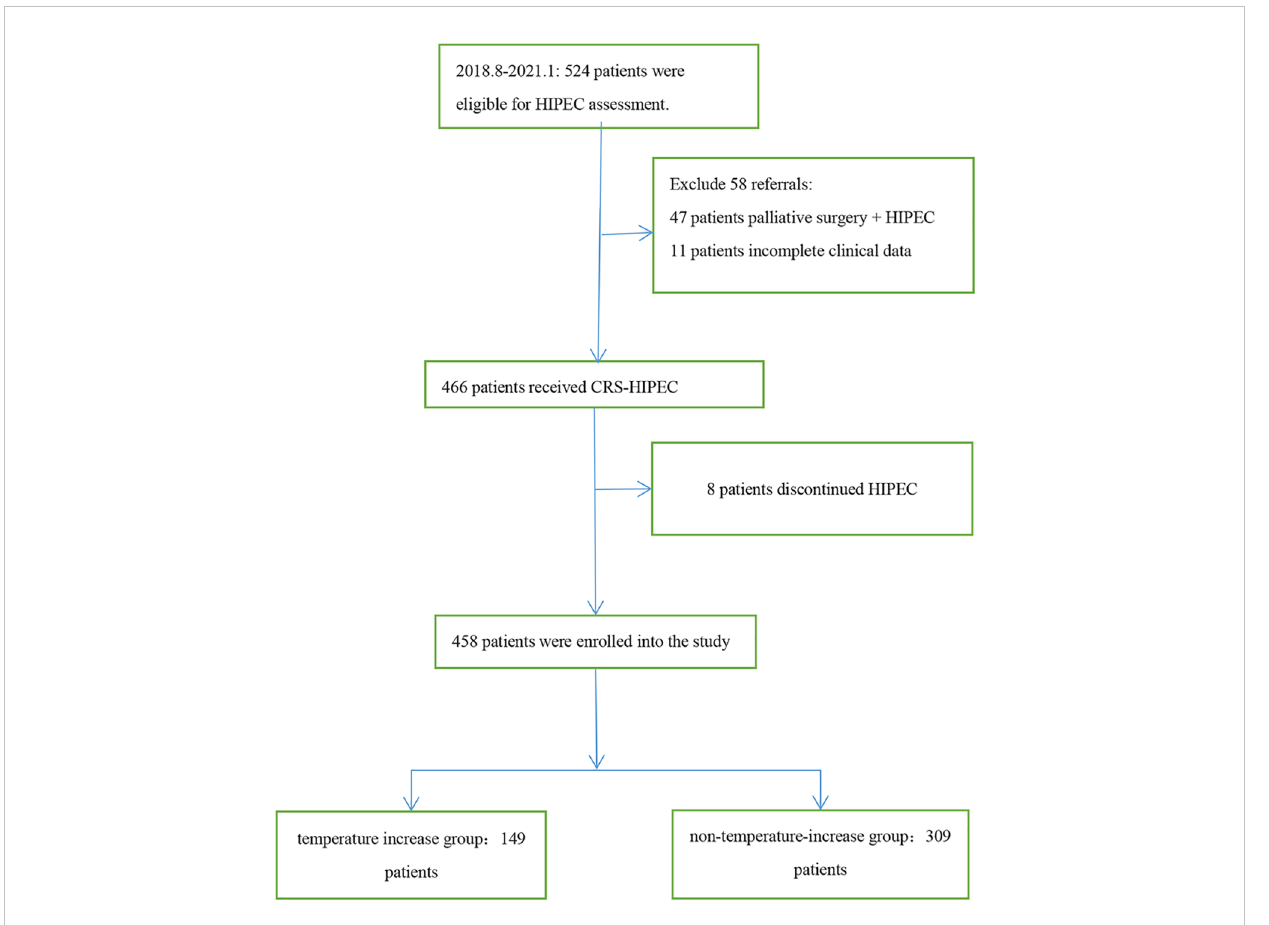
FIGURE 1 Flowchart of patient enrollment and study